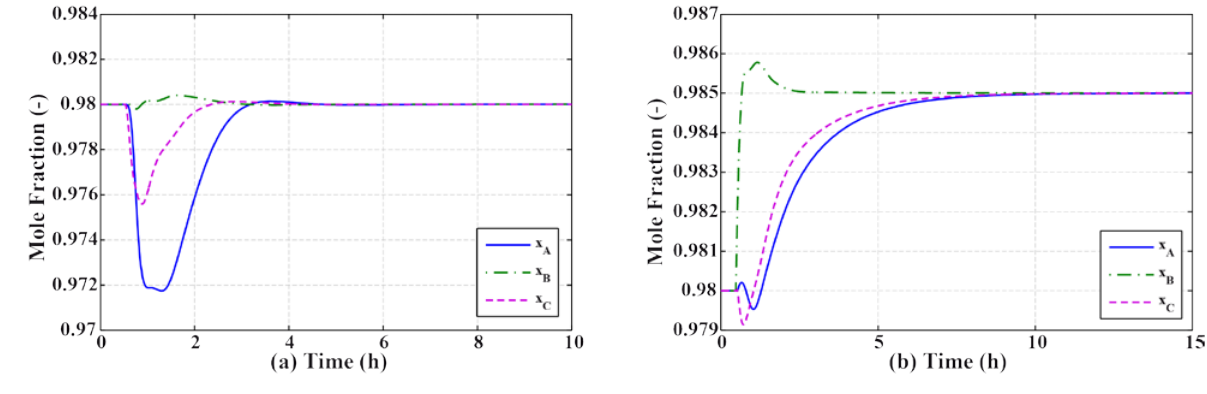
Figure 10. Dynamic response of DB-LSV control structure, ( a ) at a simultaneous disturbance of +10% in the feed flow rate and +10% in the light component composition and ( b ) +0.5% change of the setpoint.